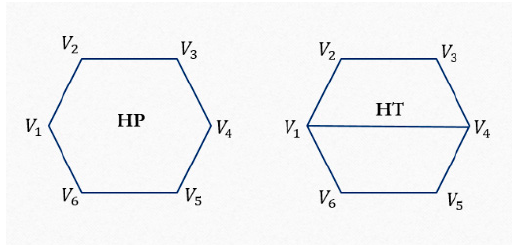
Figure 1. The system pipeline of our method.